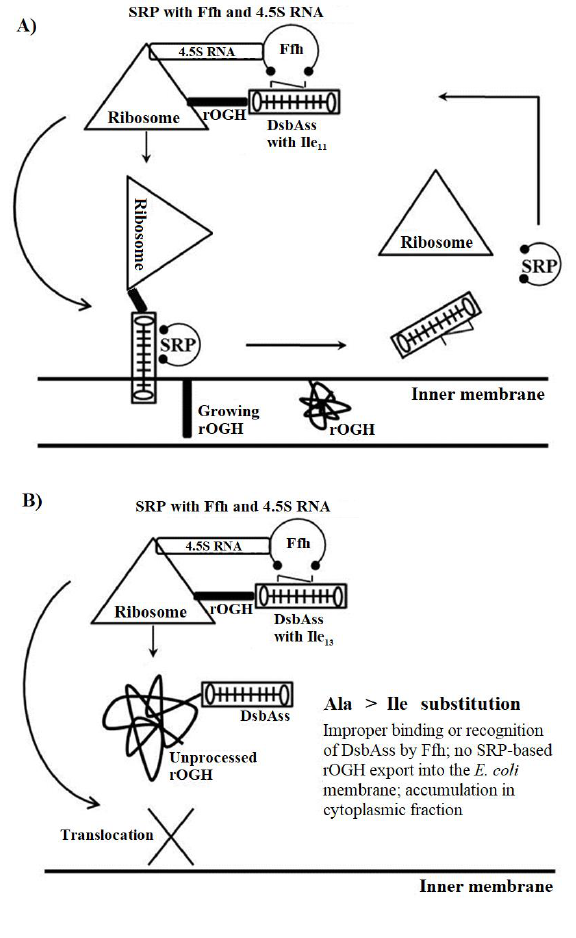
Figure 3. A model for signal repetition particle (SRP) routing of rOGH through DsbAss. ( A ) DsbAss with Ala 11 → Ile 11 substitution; ( B ) DsbAss with Ala 13 → Ile 13 substitution. Ffh: fifty-four homolog.